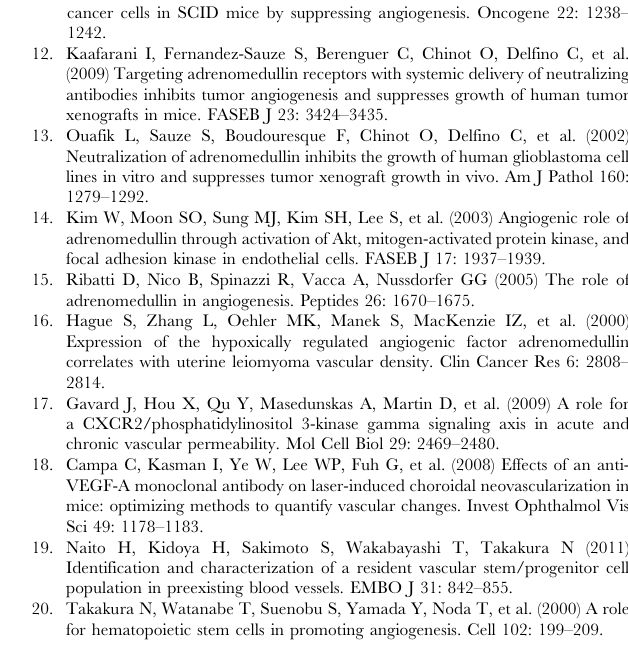
Figure S1 Toxicity experiment of ADM (22–52) using bEnd.3. proliferation assay. ADM (22–52) could inhibit the proliferation of EC at 10 nM but there was no clear toxicity even at concentration of 100 m M. (*P ,